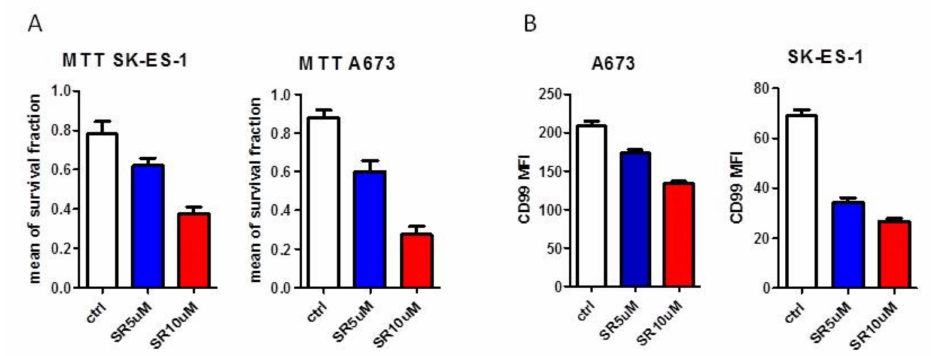
Figure 6. In vitro analysis of CD99 expression after β 3-ARs blockade. ( A ) analysis of cellular viability with MTT survival experiment in A673 and SK-ES-1 cell lines and ( B ) CD99 mean fluorescence intensity (MFI) in A673 and SK-ES-1 cells investigated by cytofluorimetric analysis, after 24 h-treatment with SR59230A 5 M (SR5uM) and 10 M (SR10uM); ctrl: